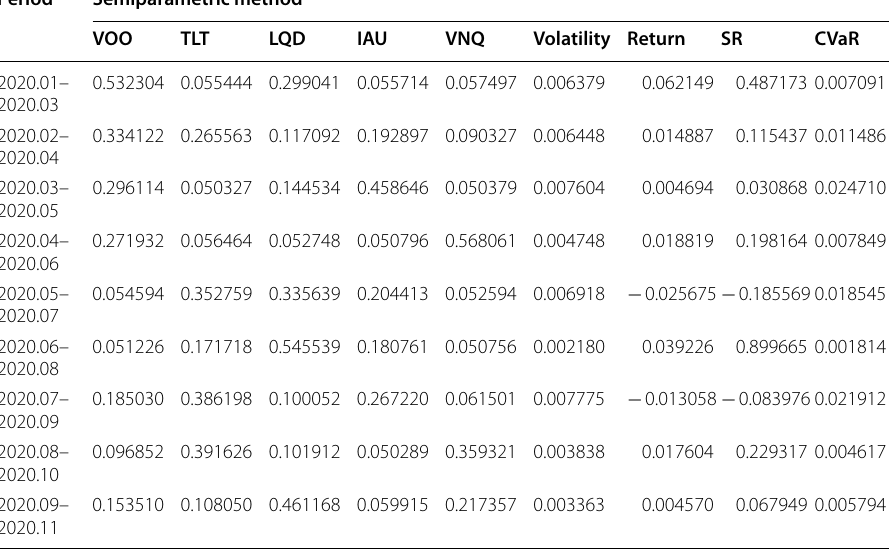
are constructed using Markowitz model and semiparametric method with CVaR ( α the total sample period (October 2015-November 2020) and estimation window is 3